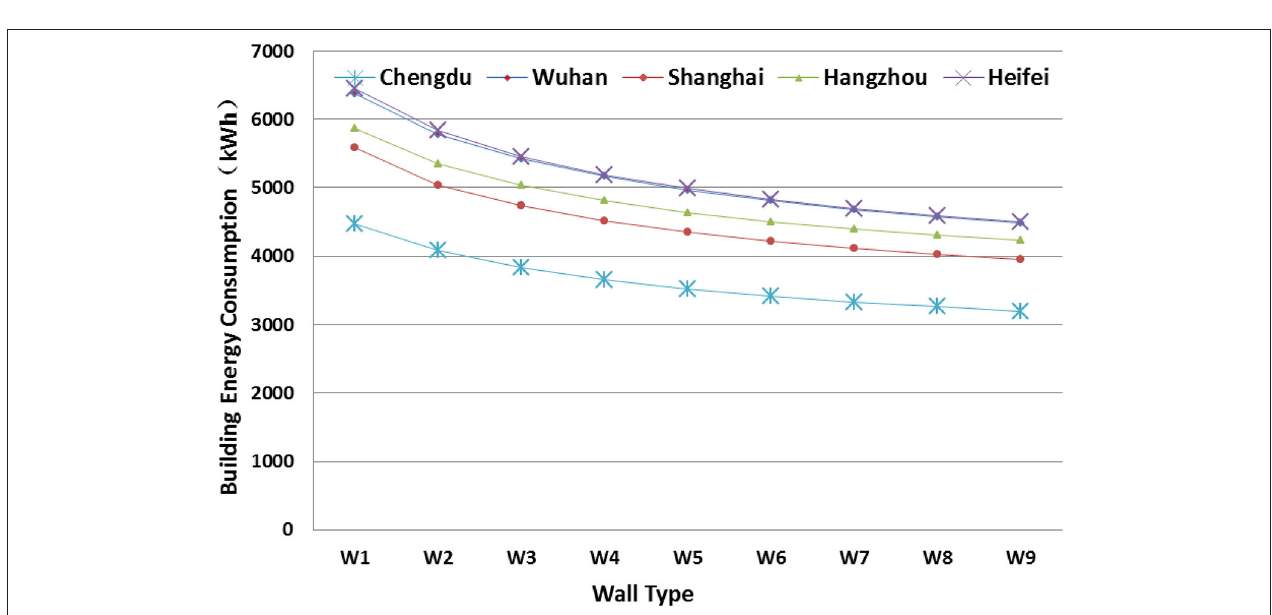
FIGURE 12 | Sensitivity analysis of wall type on annual energy